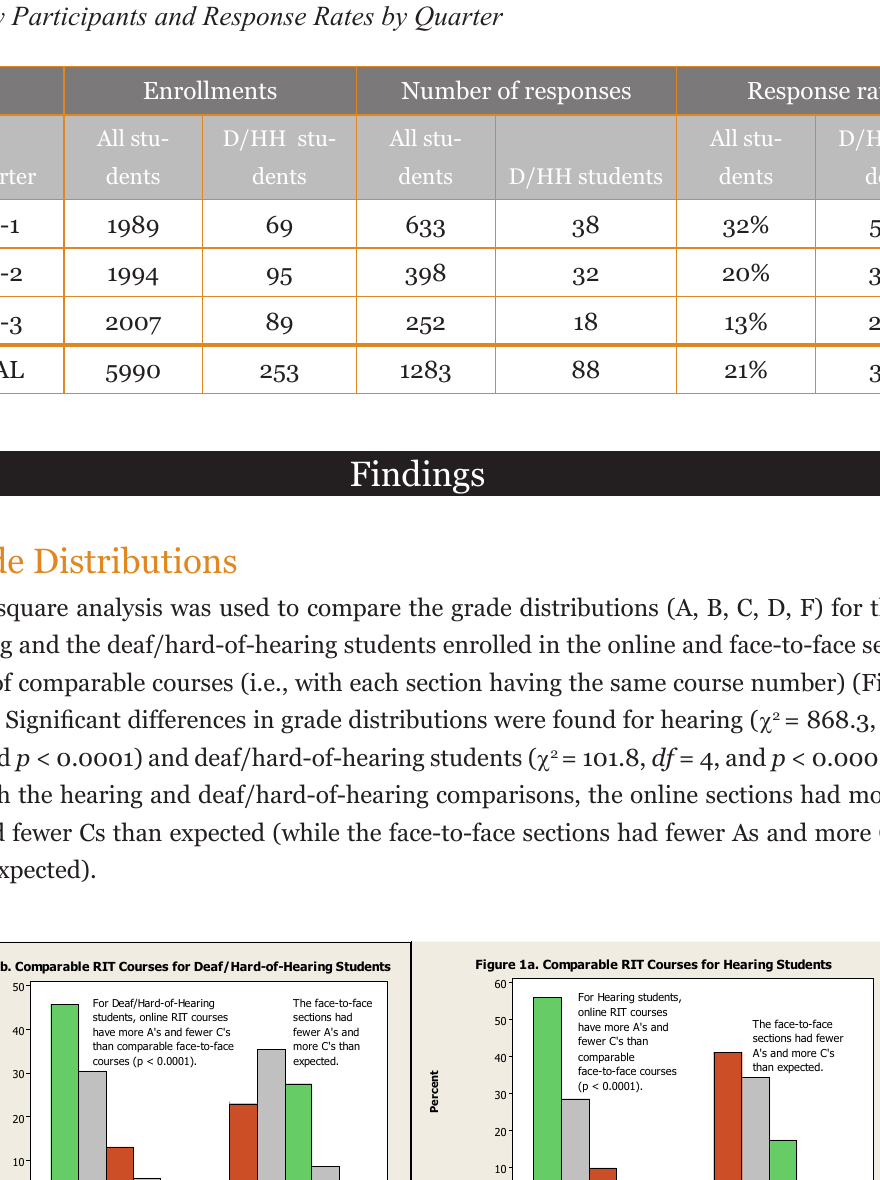
0.0001).face-to-face (p <